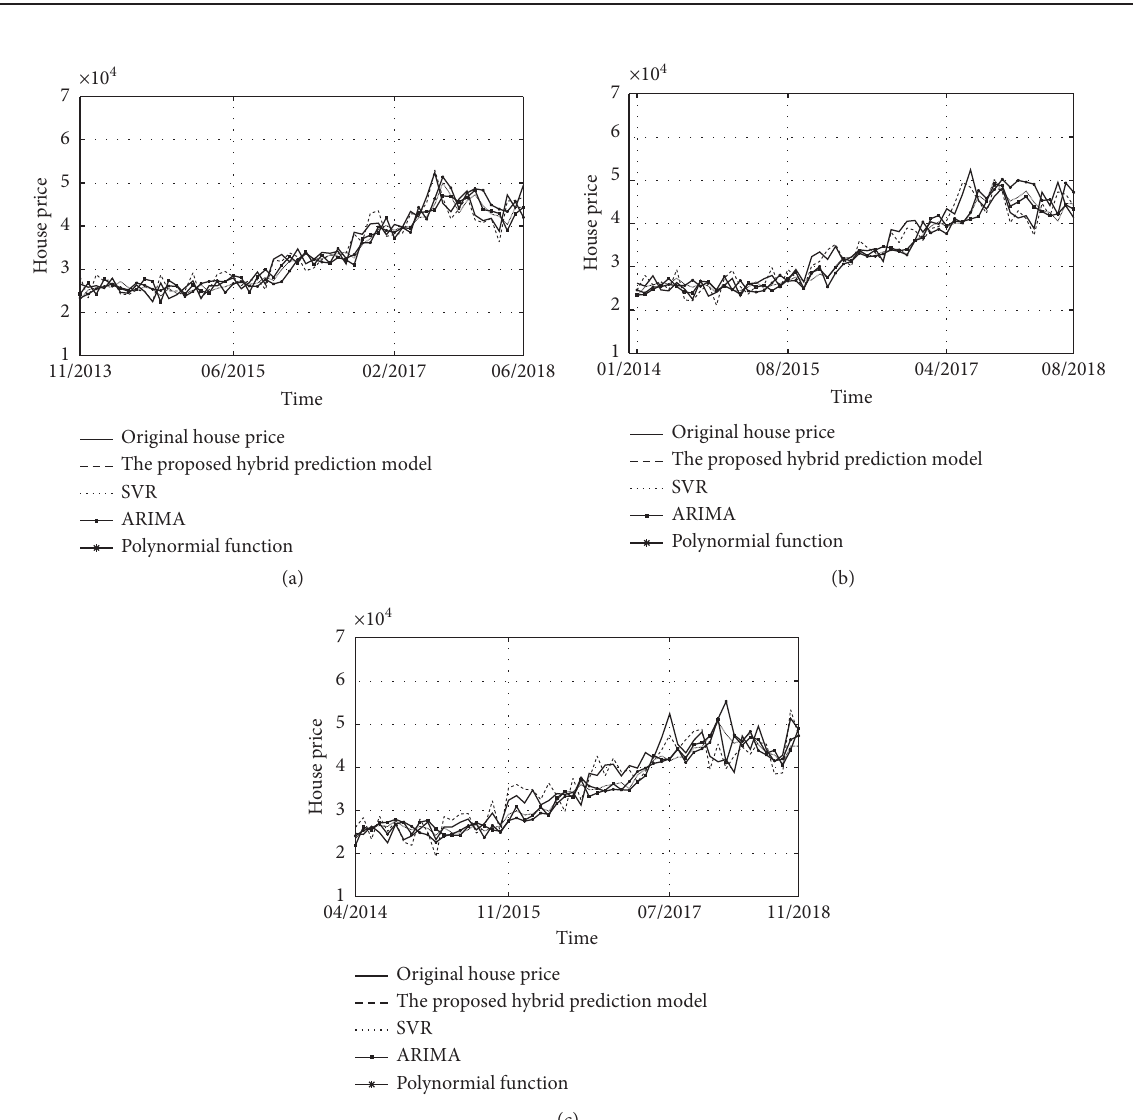
Figure 7: The original house price and forecasts of four prediction models on the out-of-sample period: (a) one-step-ahead forecasting; (b) three-step-ahead forecasting; (c) six-step-ahead